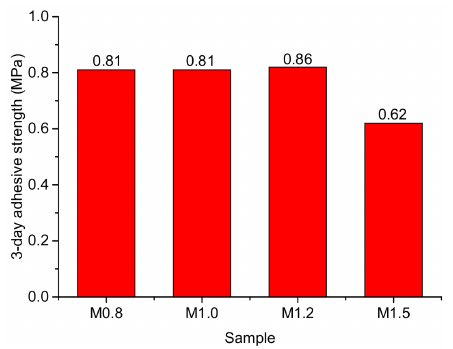
Figure 8. Adhesive strength at the age of 3 days.